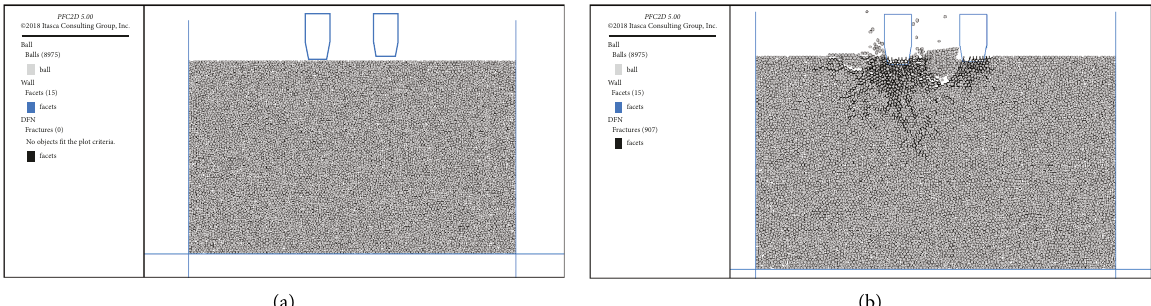
Figure 9: Rock-breaking effect of model 2: (a) before loading; (b) after loading.